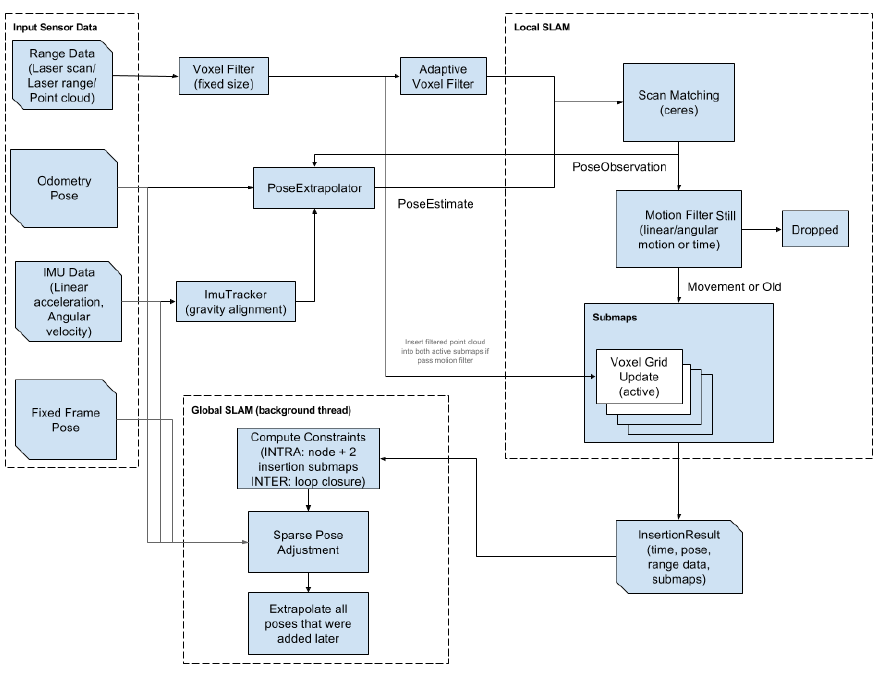
Figure 1. Block diagram of Cartographer scheme.